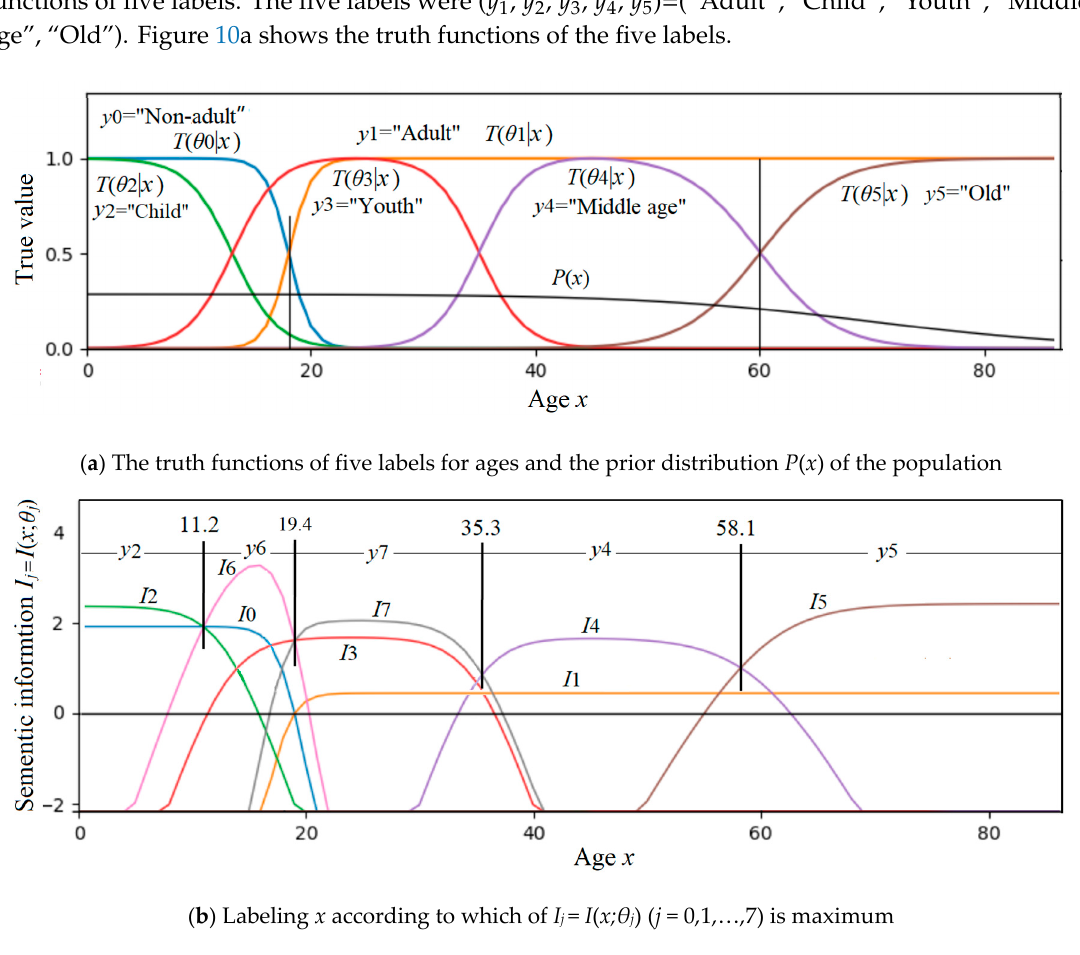
Figure 10. The maximum semantic information classification of ages.